Question: Condense the content of this figure into a single sentence.
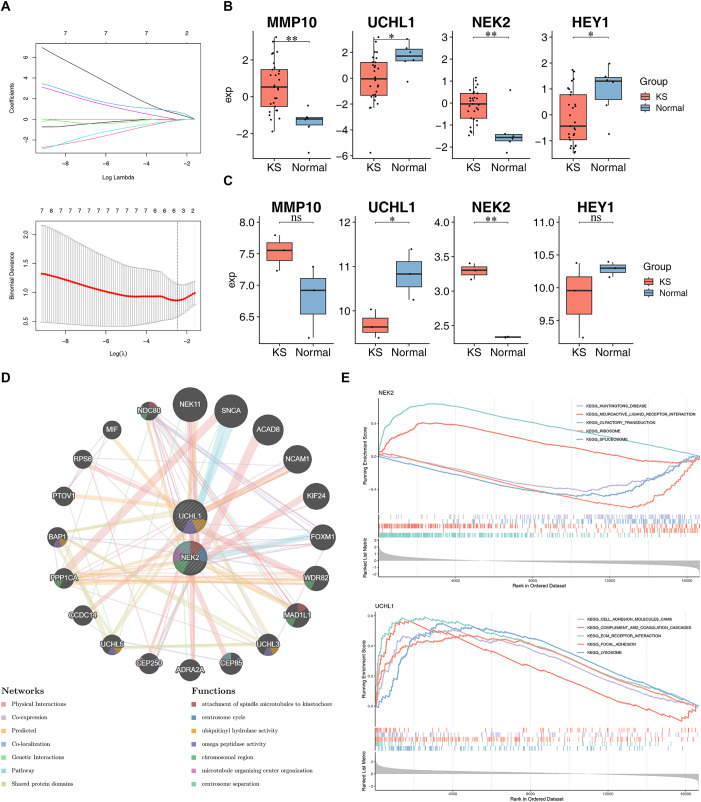
Answer: UCHL1 and NEK2 identified as diagnostic genes. (A) LASSO regression analysis. (B) Expression levels of candidate biomarkers in GSE73680 . (C) Expression levels of candidate biomarkers in GSE117518 . (D) GeneMANIA analysis of biomarkers. (E) GSEA enrichment analysis of biomarkers.